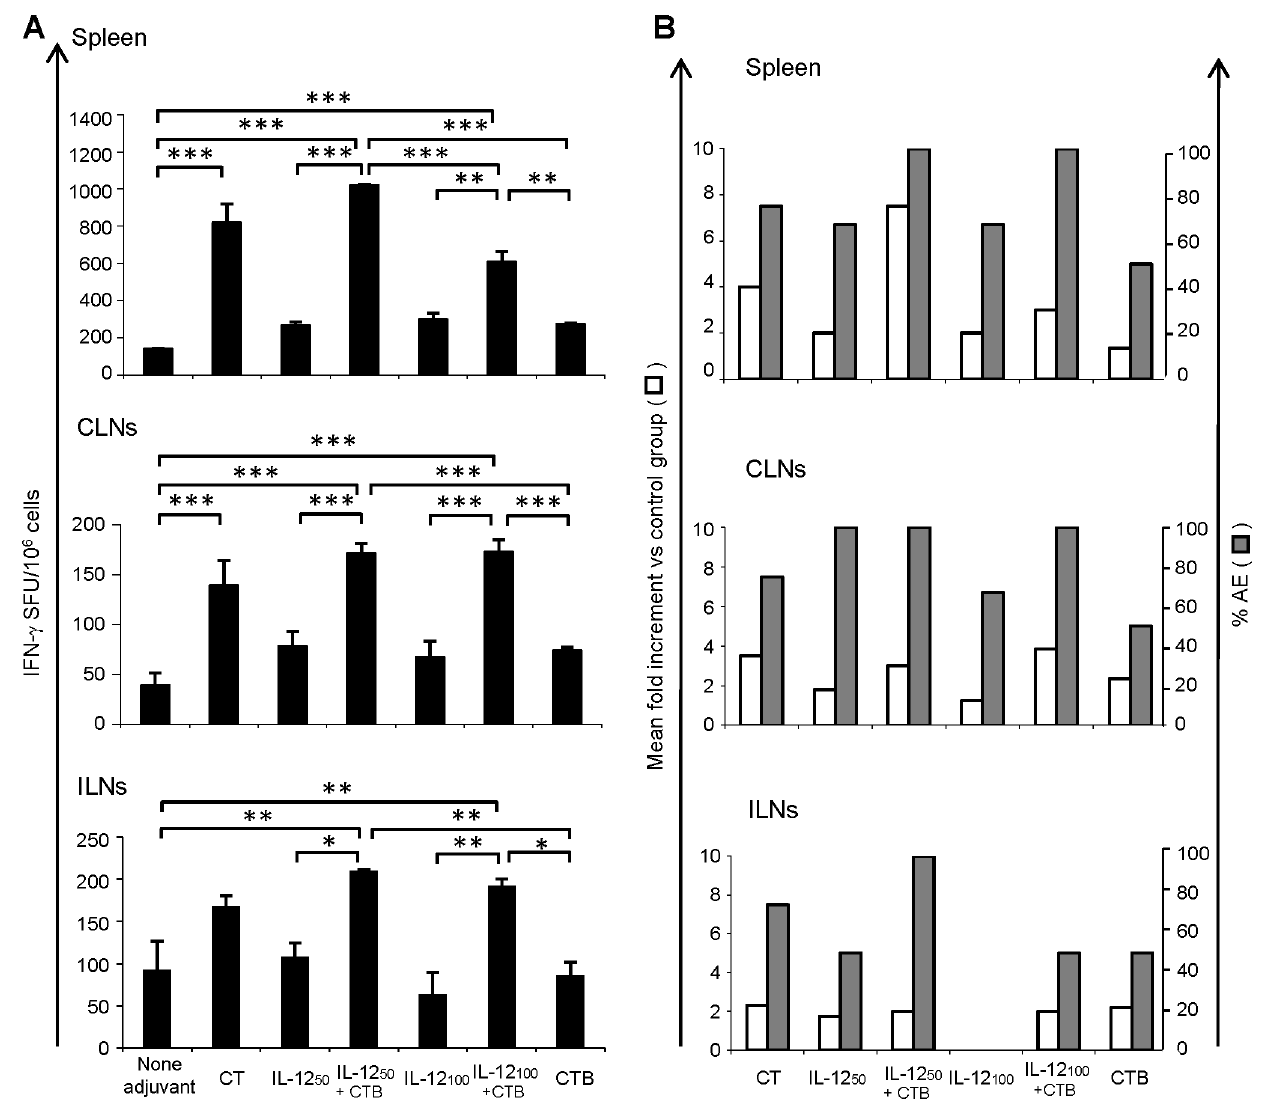
Figure 1. Nasal co-administration of DNA-IL-12 plus CTB cooperate to induce an enhancement effect in the cellular immune responses against HIV-1 Env antigen during DNA/MVA immunization schemes. Groups of four to six BALB/c mice were inoculated as described in the immunization schemes (Table 1). (A) Ten days after the booster dose, specific cellular immune responses (IFN- c secreting CD8 T-cells) against Env were quantified by ELISPOT using pooled cells from spleen, cervical lymph nodes (CLNs) and iliac lymph nodes (ILNs). Bars represent the average number of specific IFN- c spots forming units (SFU)/10 6 cells + SD of a representative experiment from 2 to 6 performed. Each determination was evaluated in duplicate or triplicate and background values from negative control wells were subtracted. Statistical differences between indicated groups: *p , 0.05; **p , 0.01; ***p , 0.001; by one-way ANOVA test and Bonferroni’s correction post-test. (B) Summarize of the results obtained in all the experiments performed. Left bars (white) represent the mean fold increments in the magnitude of the specific cellular immune response compared to the control group. Right bars (grey) represent the percentage of experiments with adjuvant efficacy (%AE); %AE: represents a significant increase in the specific cellular immune response induced compared to the control group.